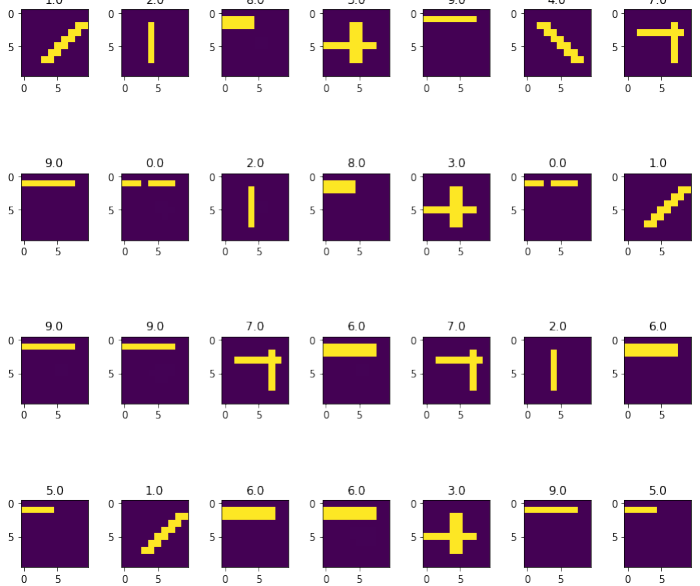
Figure 8. Cluster results of 28 samples, images shown are heterogeneous fields, the number on top of each image is the cluster assignment ID